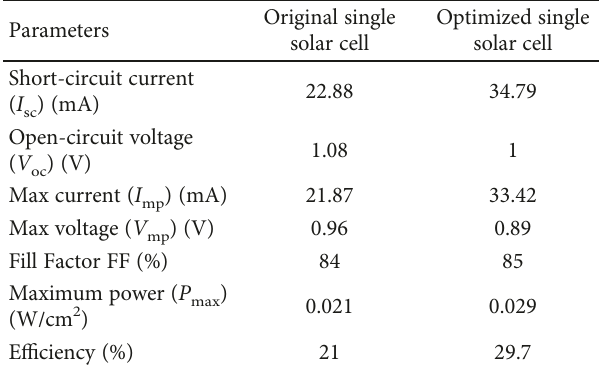
Figure 6: Final GaAs optimized structure.